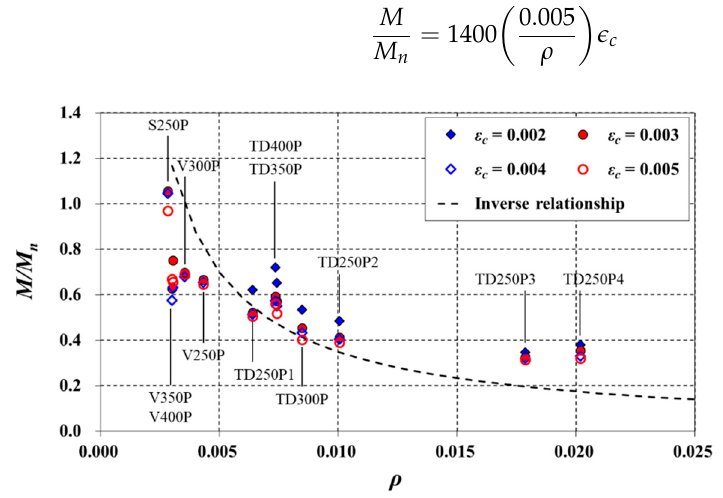
Figure 12. Variations of M / M n with ρ .